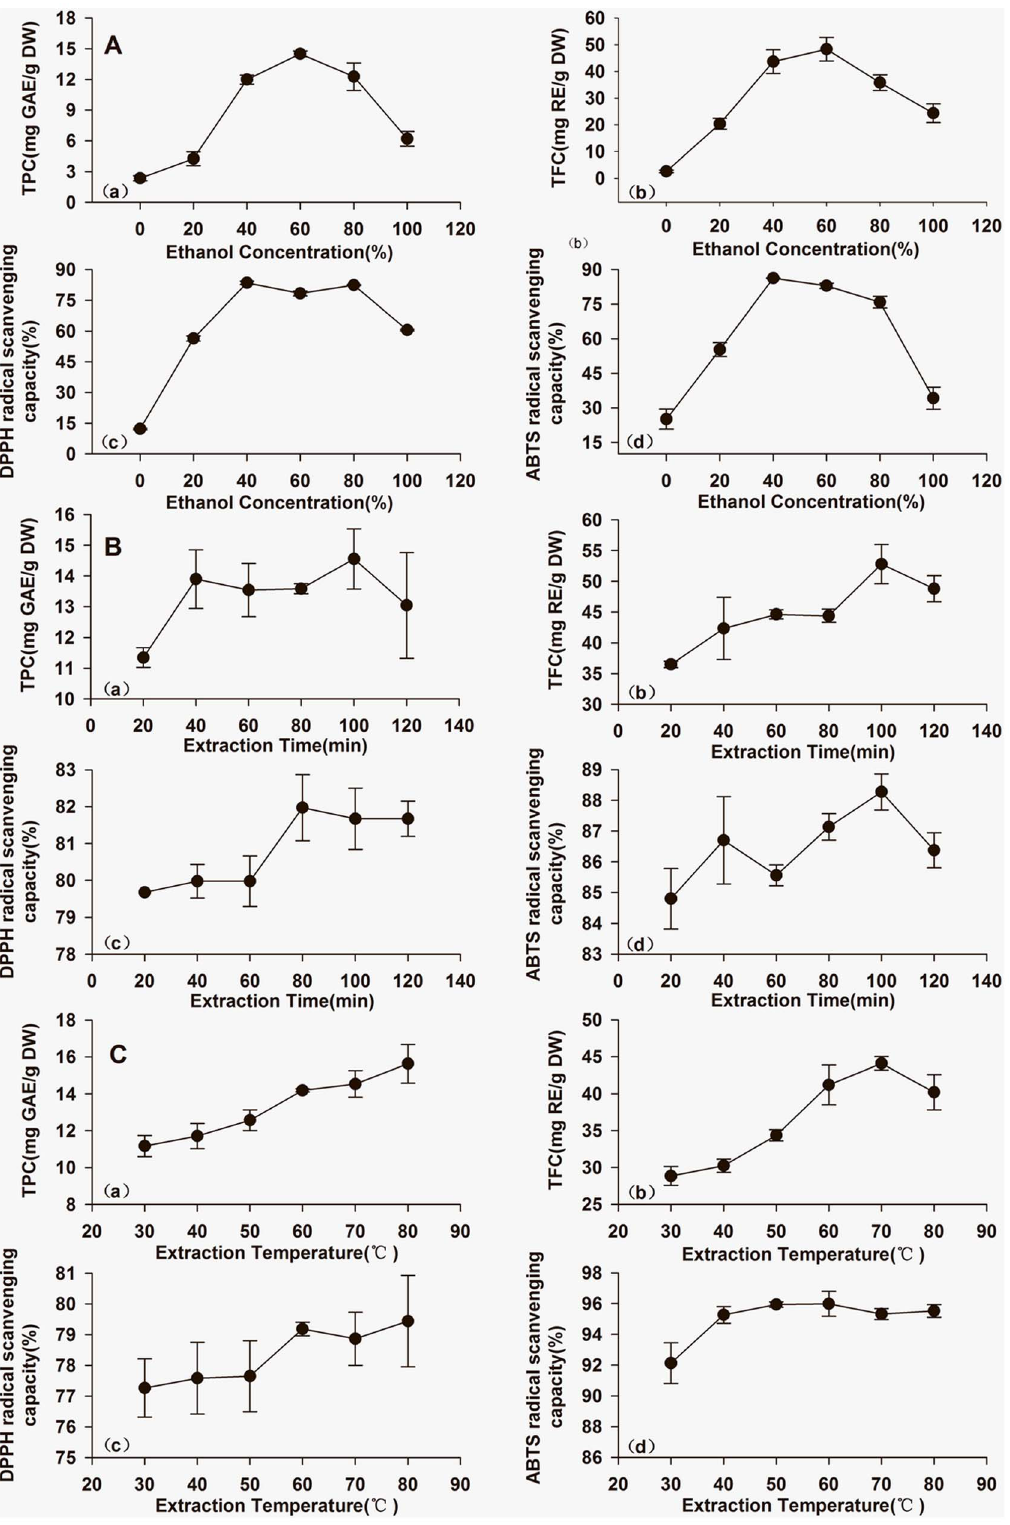
Figure 1. Effect of (A) ethanol concentration (extraction time 60 min, extraction temperature 60 6 C), (B) extraction time (40% ethanol, extraction temperature 60 6 C), (C) extraction temperature (40% ethanol, extraction time 80 min) on TPC, TFC, DPPH and ABTS radical scavenging capacity from C.cyrtophyllum leaf extracts.